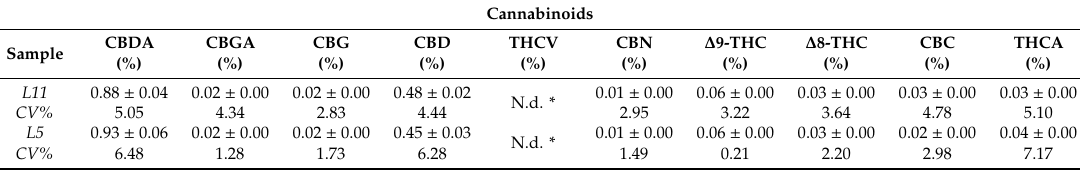
Table 2. Number of cannabinoids in hemp